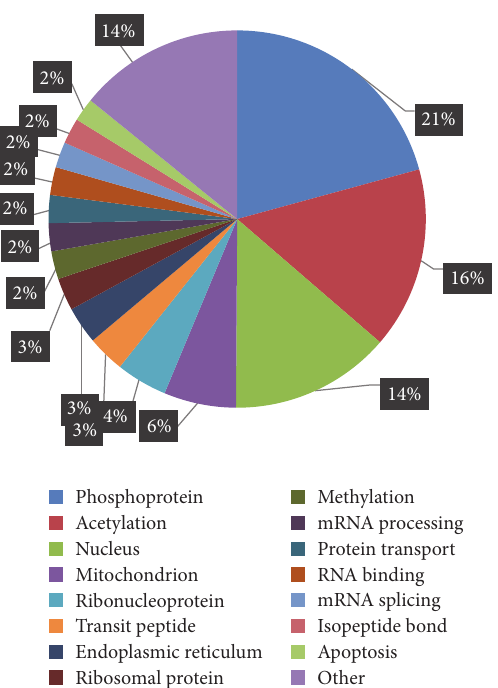
Figure 3: The functional categories of the dysregulated proteins are shown in a pie. It shows that phosphoprotein and acetylation proteins contributed the most proportion in the dysregulated